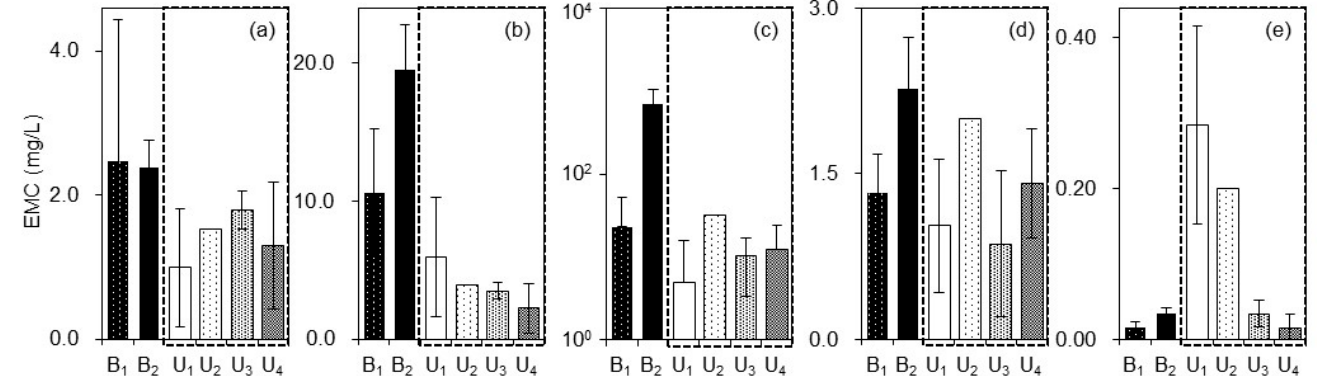
Figure 7. Event mean concentration (EMC) of pollutant parameters (( a ) BOD, ( b ) COD, ( c ) TSS, ( d ) TN and ( e ) TP) between burned (in this study, B 1 and B 2 ) and unburned (in previous studies, U 1 , U 2 , U 3 , and U 4 ) headwater catchments. B 1 and B 2 indicate EMC of pollutant parameters in the spring and summer, respectively. U 1 , U 2 , U 3 , and U 4 indicate the EMC of pollutant parameters in Yur and Kim [97], Kang et al. [98], Yoon et al. [99], and NIER [100], respectively. Four unburned catchments were focused on forested headwater catchments from spring to summer. BOD: biological oxygen demand, COD: chemical oxygen demand, TSS: total suspended solids, TN: total nitrogen, TP: total phosphorus.